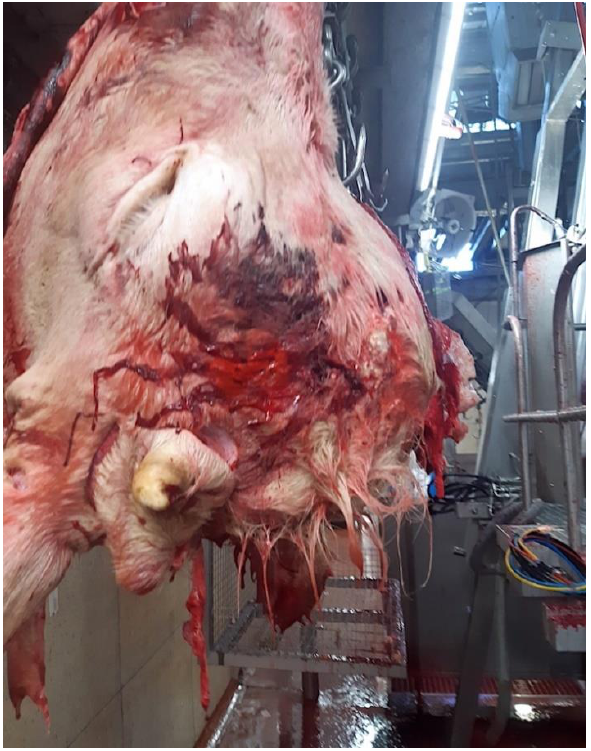
Figure 2. The head removed from carcass (Left Hand Side) .